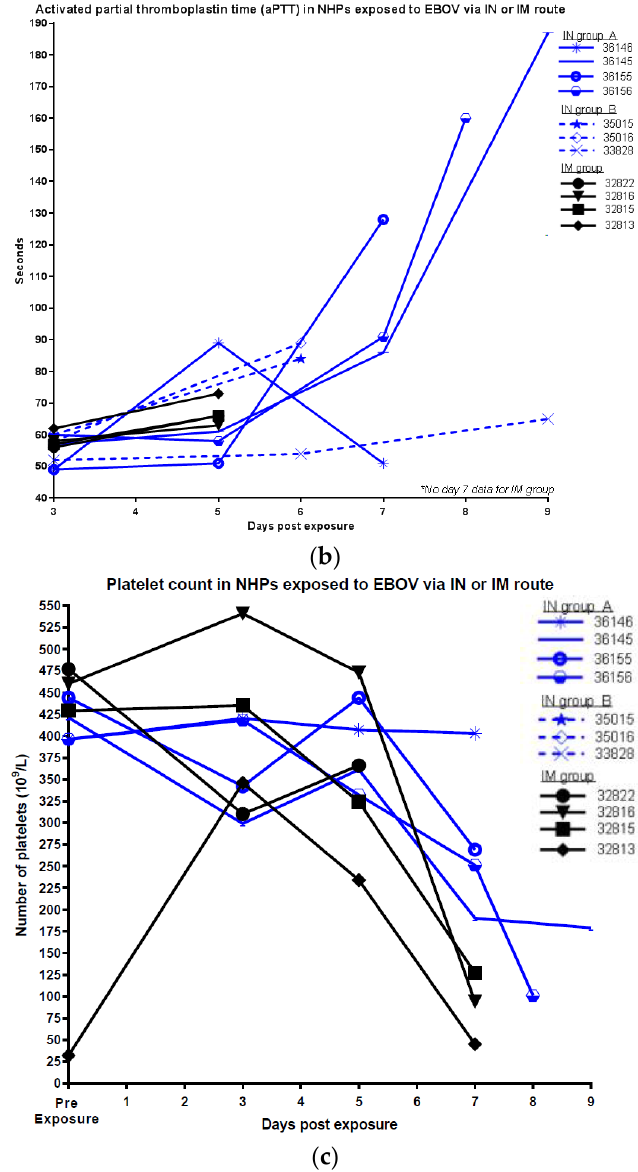
Figure 3. Coagulation tests of EBOV infected NHPs exposed via IM or IN route; ( a ) PT; ( b ) aPTT, *no day 7 data for IM group; ( c ) platelets.